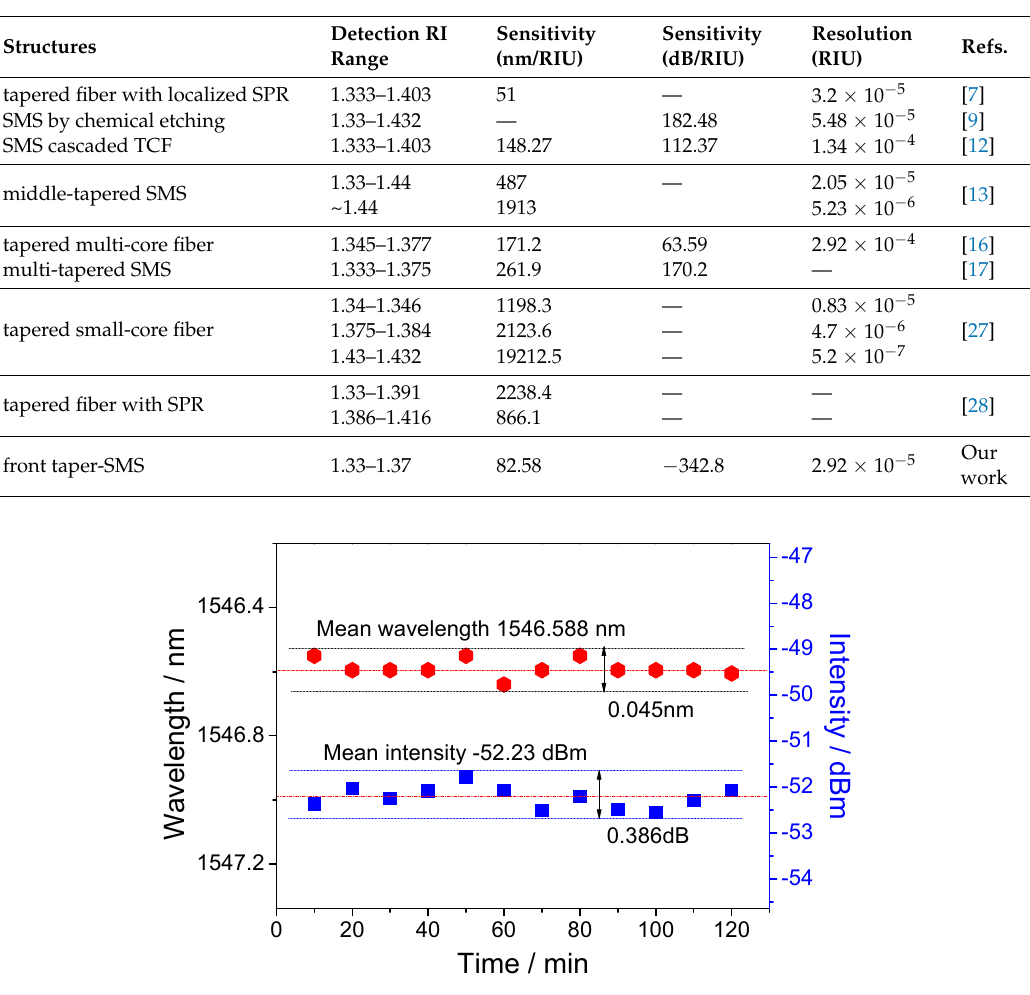
Figure 7. Stabilities in terms of wavelength and intensity within 2 h.